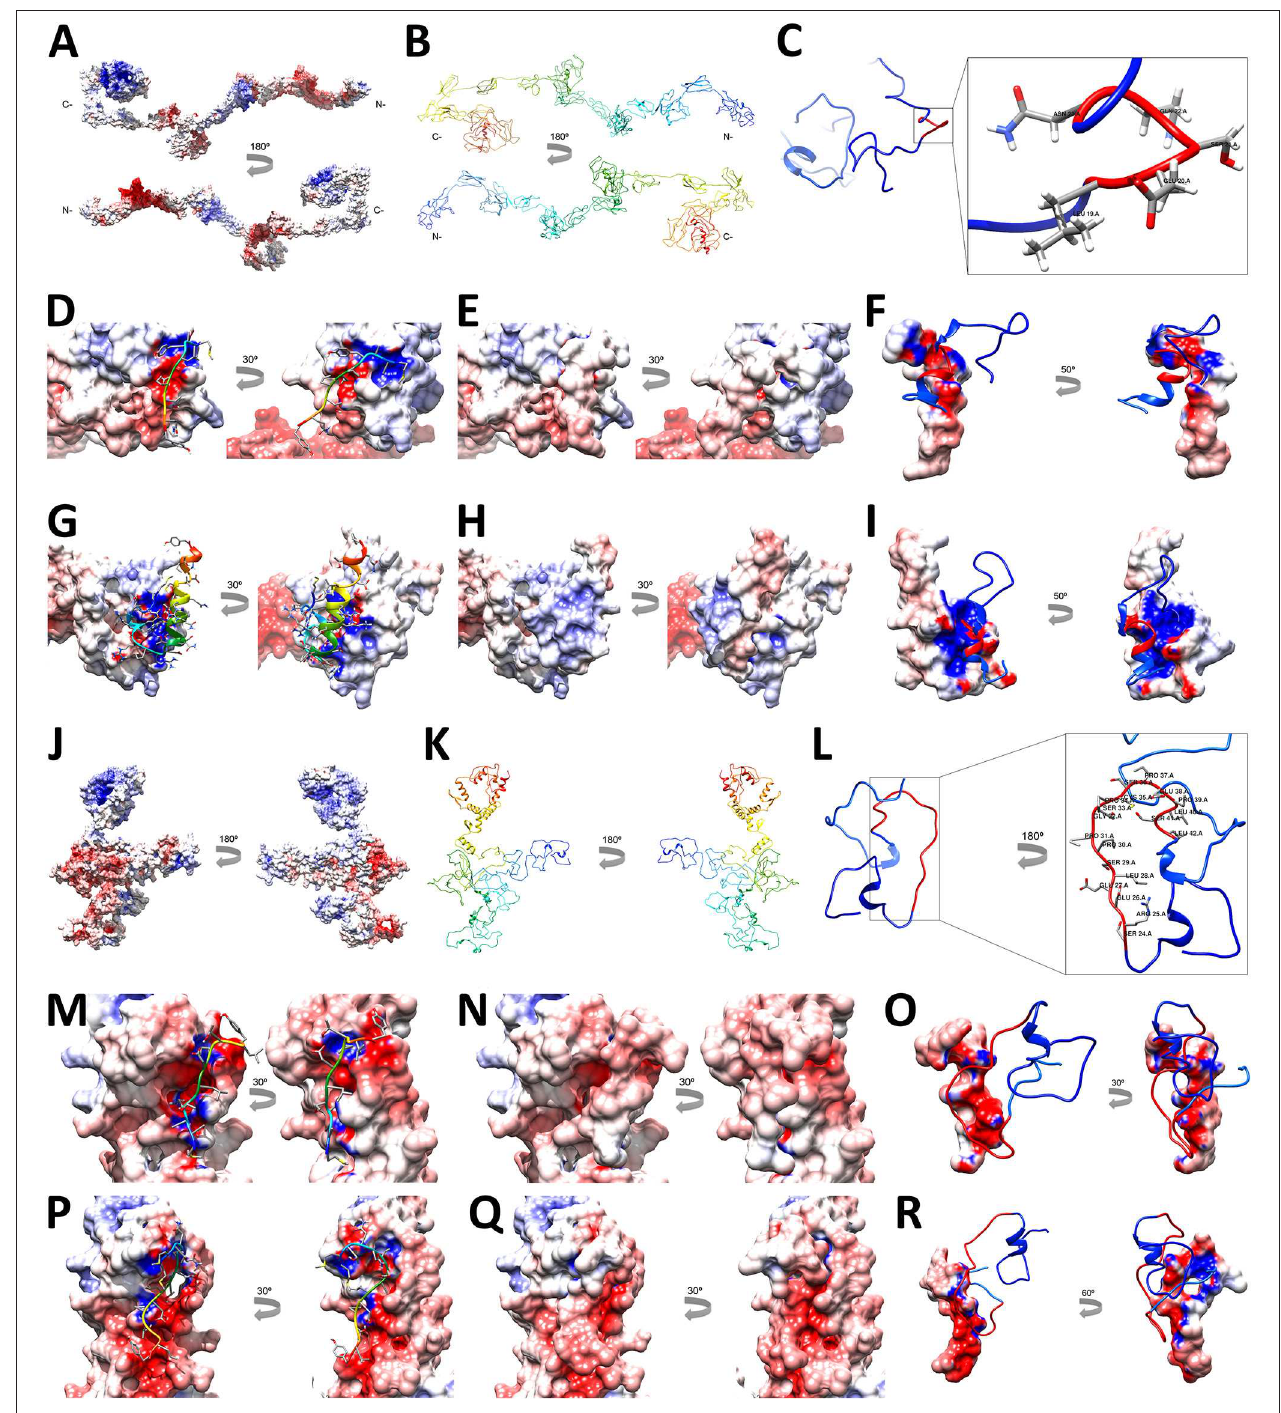
FIGURE 2 | Shavenbaby-Mlpts interaction prediction. The Svbs-Mlpts docking assays were based on (Zanet et al., 2015) findings and on the analysis of protein binding sites prediction in the Svbs N-termini by DISOPRED. The electrostatic potential was represented on the molecular surface of Dmel-Svb (A,D,E,G,H) , Dmel-Mlpt1 (E,F) , Dmel-Mlpt4 (H,I) , Rprol-Svb (D,J,M,N,P,Q) , Rprol-Mlpt1 (N,O) , Rprol-Mlpt2 (Q,R) , with negative values ( − 10 keV) in red, neutral in white, and positive values ( + 10 keV) in blue. Dmel-Svb (B) and Rprol-Svb (K) ribbons (figure downside) were colored from blue to red to indicate the progression of the N- to C-terminal, respectively. The N-terminal (C,L) was enlarged and the predicted protein-binding site region Leu19-Asn23 was depicted in red for Dmel-Svb (C) and the region Ser24-Leu42 for Rprol-Svb (L) . Dmel-Mlpt1 (D) , Dmel-Mlpt4 (G) , Rprol-Mlpt1 (M) and Rprol-Mlpt2 (P) are represented as ribbon, colored from blue to red as the polypeptide chain progresses from the N- to the C-terminus, each one in your respective docking region on Shavenbaby surface. The Mlpts side-chains residues are shown as sticks.